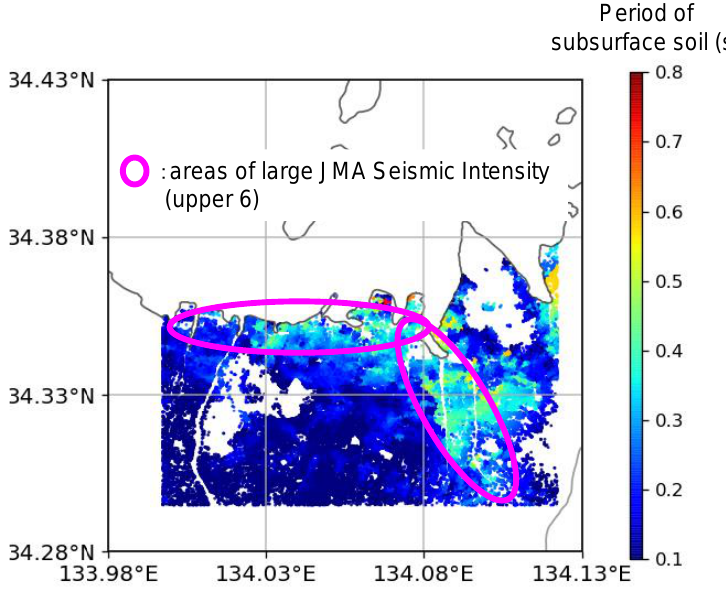
Figure 3. Distribution of natural period of the automatically constructed analysis models.